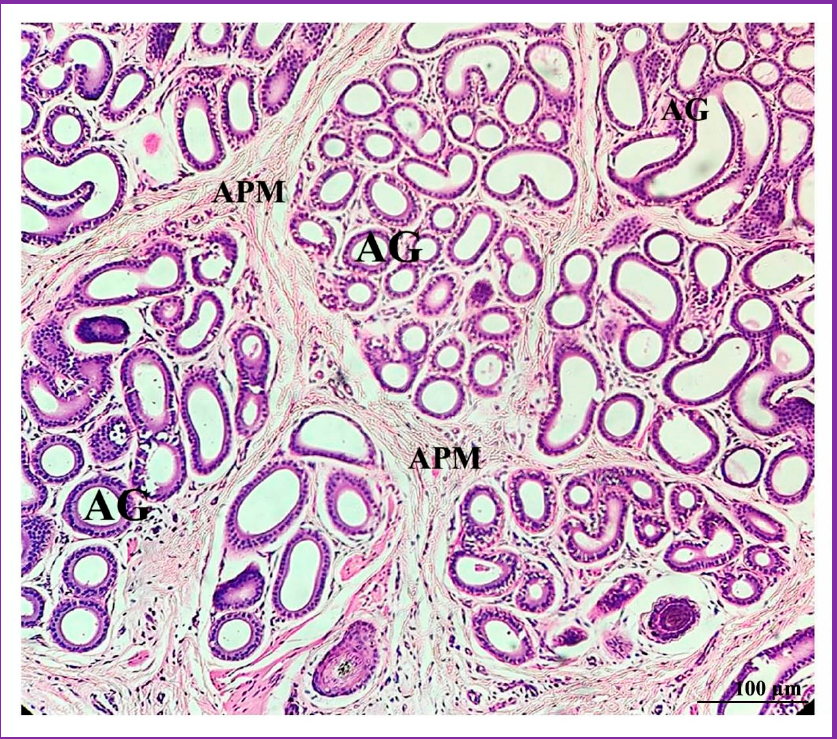
Figure 6. Photomicrograph of the interdigital sinus of male Vembur sheep showing clusters of apocrine secretory lobules (AG). Arrector pili muscles (APM) are found around the secretory glands (apocrine and sebaceous) and the hair follicles placed in the dermal region.